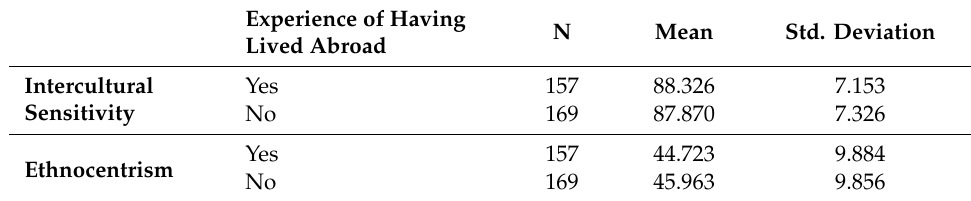
Table 16. The Mean and standard deviation scores of the students by their experience of having lived abroad in the Intercultural Sensitivity Scale and the Ethnocentrism Scale. N Mean Std.